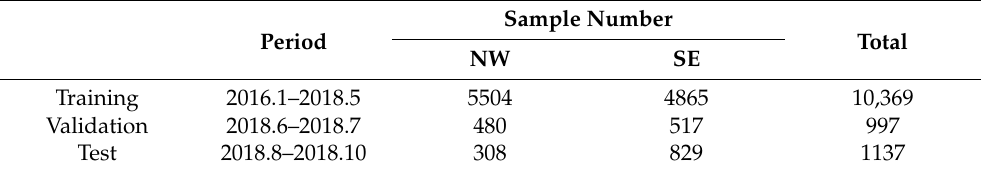
Table 1. The divided subsets for training, validation, and testing.